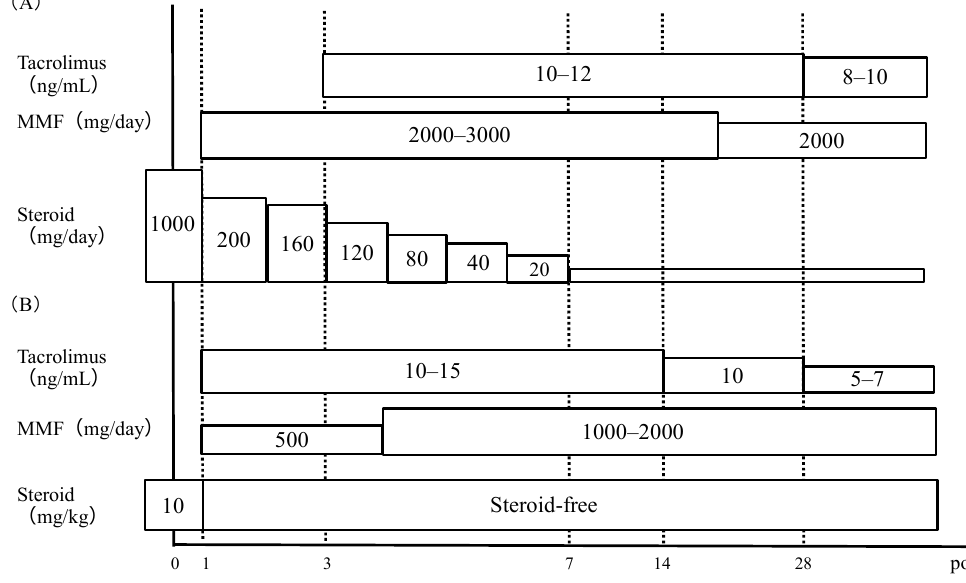
Figure 3. Immunosuppression protocols. ( A ) Kyushu University Hospital. ( B ) Kyoto University Hospital. MMF, mycophenolate mofetil; pod, postoperative day.